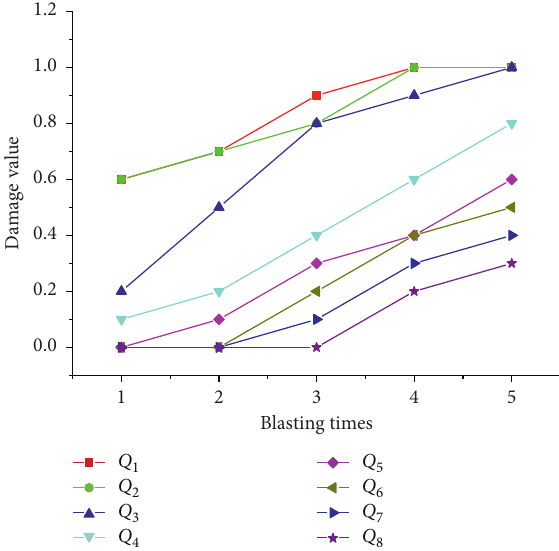
Figure 16: The curve of the relationship between cumulative damage of rock anchor beam monitoring points perpendicular to the axis of powerhouse and blasting